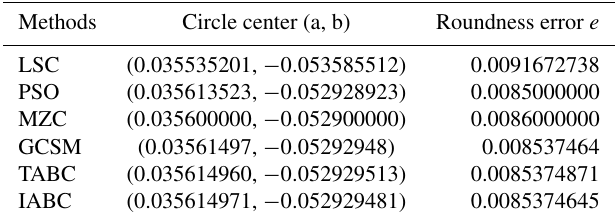
Table 4. Comparison of data processing